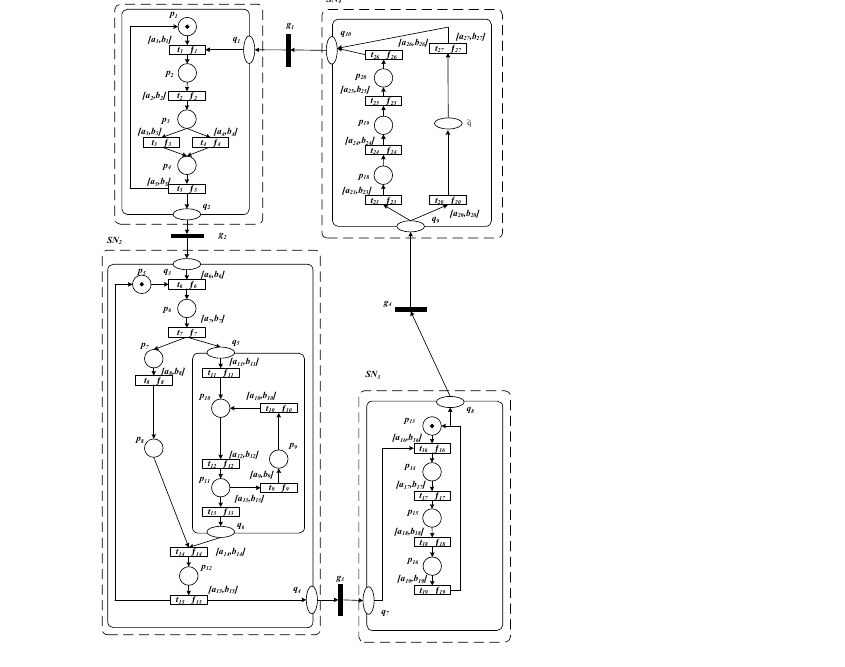
Figure 6. Σ (cid:2869) = {𝑁 (cid:2869) , 𝐹 (cid:2869) ,𝐺 (cid:2869) , 𝑀 (cid:2869) } obtained using the Q-type internal subnet reduction rule. Figure 6. Σ 1 = { N 1 , F 1 , G 1 , M 1 } obtained using the Q-type internal subnet reduction rule. Note that, the boundedness and liveness of the OOPRES net system Σ = {𝑁, 𝐹, 𝐺, 𝑀} , As shown in Figure 7, the TQ-type internal-subnet (generated by { p 2 , p 3 , p 4 , t 1 , t 2 , t 3 , t 4 , t 5 } Σ = {𝑁 , 𝐹 , 𝐺 , 𝑀 } and Σ = {𝑁 , 𝐹 , 𝐺 , 𝑀 } in Figures 5–7 can also be veri fi ed by the of SN 1 , the TQ-type internal subnet (generated by { p 6 , p 7 , p 8 , p 9 , p 10 , p 11 , p 12 , t 6 , t 7 , t 8 , t 9 , t 10 , t 11 , (cid:2869) (cid:2869) (cid:2869) (cid:2869) (cid:2869) (cid:2870) (cid:2870) (cid:2870) (cid:2870) (cid:2870) modeling tool software Tina 3.7.0. (Tina 3.7.0 is a simulation tool used only for simulation t 12 , t 13 , t 14 , t 15 , q 5 , q 6 }) of SN 2 , the TQ-type internal subnet (generated by { p 14 , p 15 , p 16 , t 16 , t 17 , analysis and viewing property analysis results.) The veri fi cation of boundedness and t 18 , t 19 }) of SN 3 , and the TQ-type internal subnet (generated by { p 18 , p 19 , p 20 , t 23 , t 24 , t 25 , t 26 }) of SN 4 of the OOPRES+ net system model Σ 1 = { N 1 , F 1 , G 1 , M 1 } are reduced to the transitions t 28 , t 29 , t 30 , and t 31 , respectively, and then the reduced net system Σ 2 = { N 2 , F 2 , G 2 , M 2 } is obtained. It is easy to know that each place of the above four the TQ-type internal sub- nets is bounded and each transition is live. Since the above the TQ-type internal subnet reductions satisfy the conditions of Theorems 3 and 4, it is easy to see that the net system Σ = { N = { N } is bounded and live if and only if Σ } is bounded 2 2 , F 2 , G 2 , M 2 1 1 , F 1 , G 1 , M 1 and